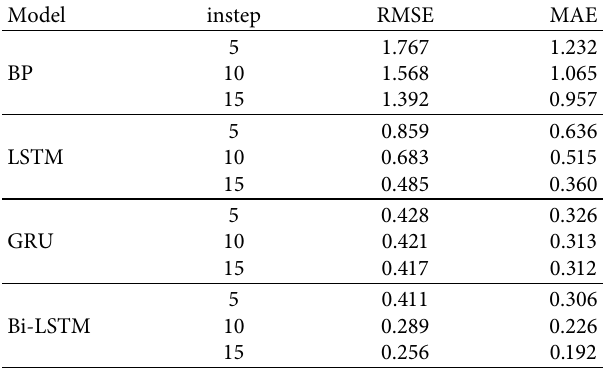
× h Prediction performance in test set. 50 50